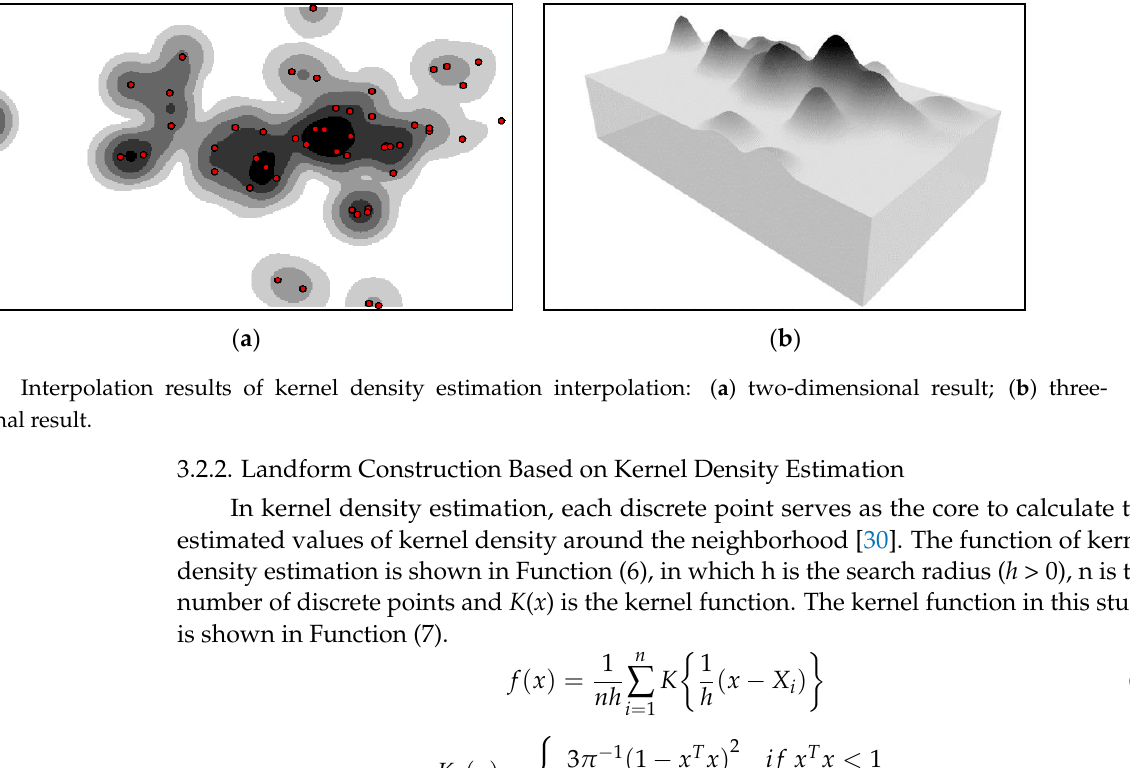
Figure 3. Spatial positioning of sub-nodes in hierarchical data.